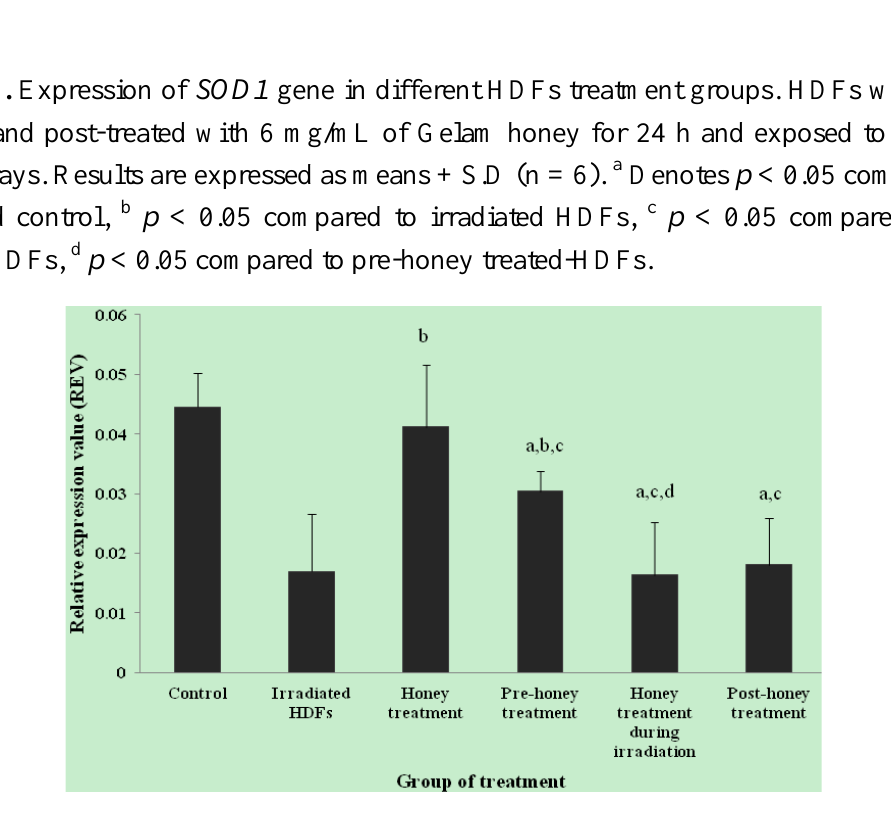
Figure 2. Expression of SOD2 gene in different HDFs treatment groups. HDFs were pre-, during- and post-treated with 6 mg/mL of Gelam honey for 24 h and exposed to 1 Gy of gamma rays. Results are expressed as means + S.D (n = 6). a Denotes p < 0.05 compared to untreated control, b p < 0.05 compared to irradiated